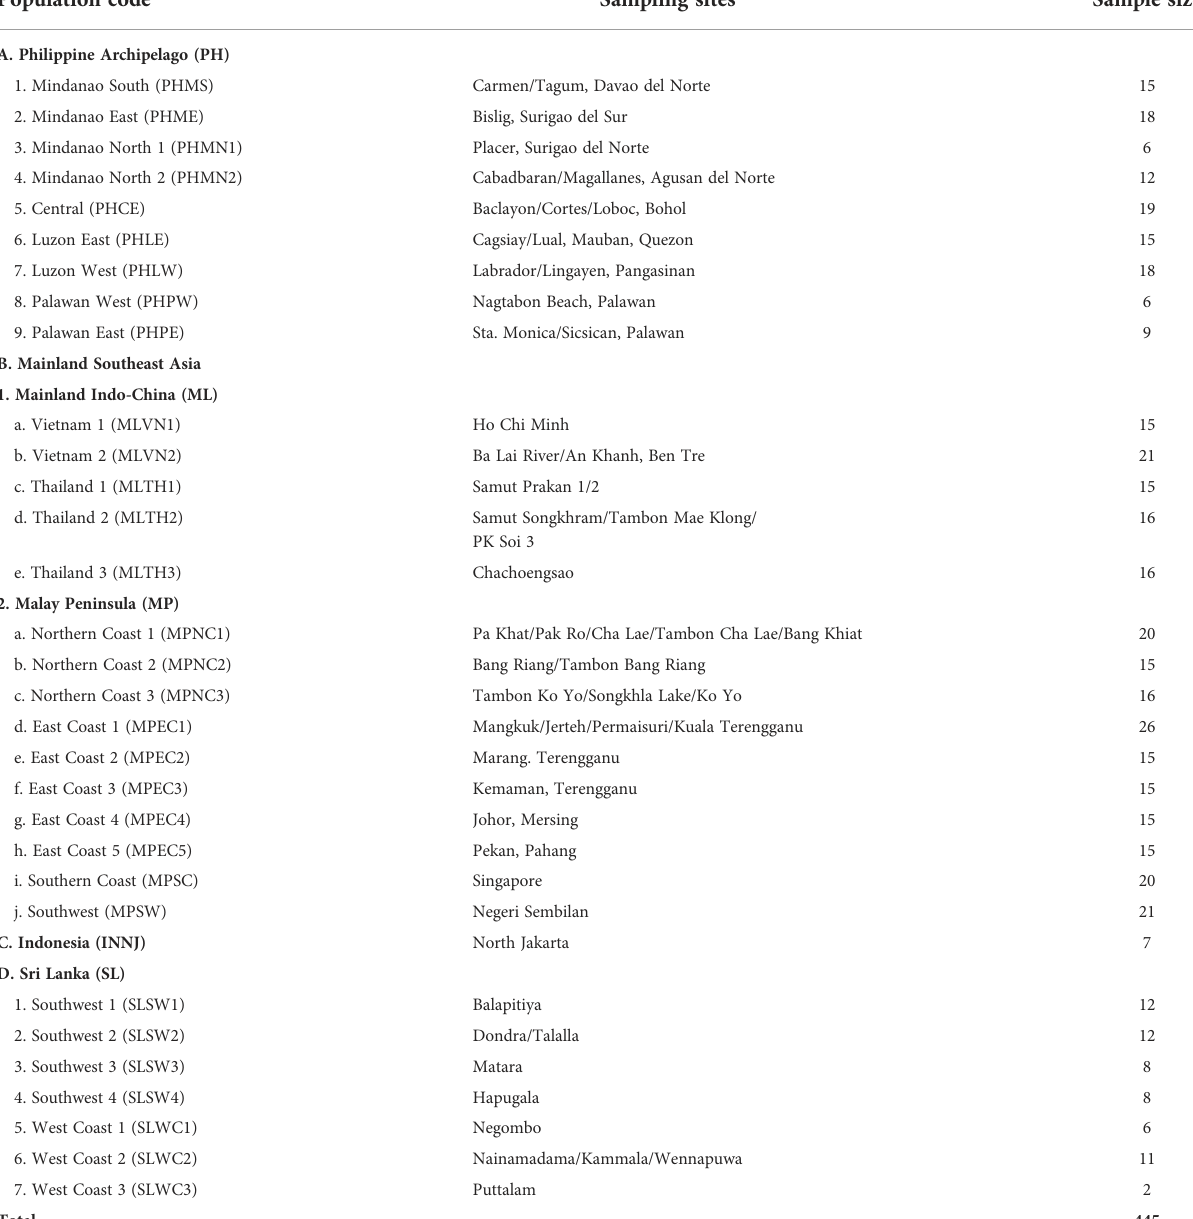
TABLE 1 The different sampling sites of nipa populations and their corresponding sampling sizes in the Indo-West Paci fi